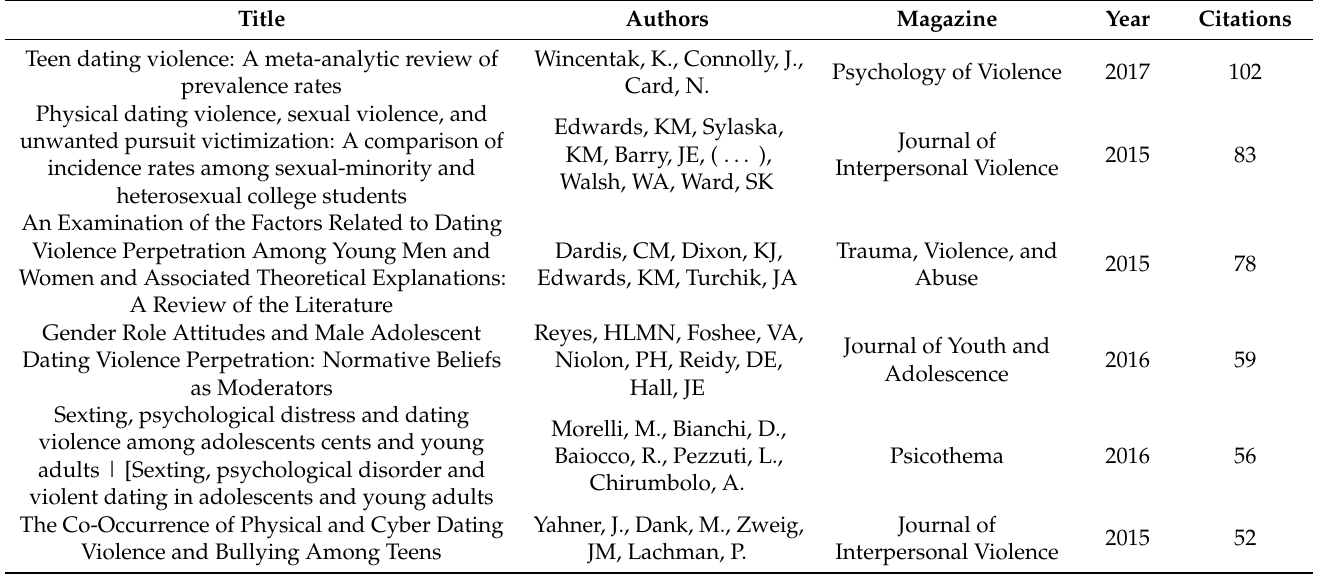
Table 4. Most cited references in Scopus.